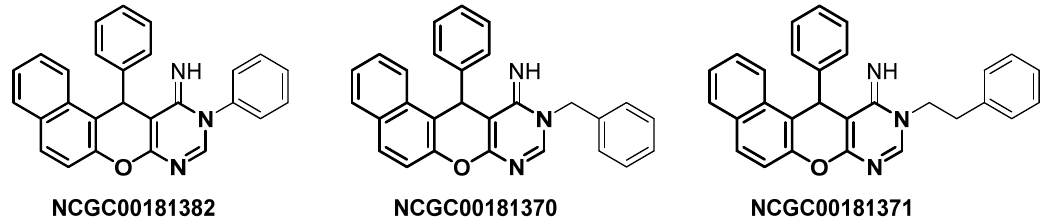
Figure 3. Naphthopyranopyrimidine-based biologically active molecules.